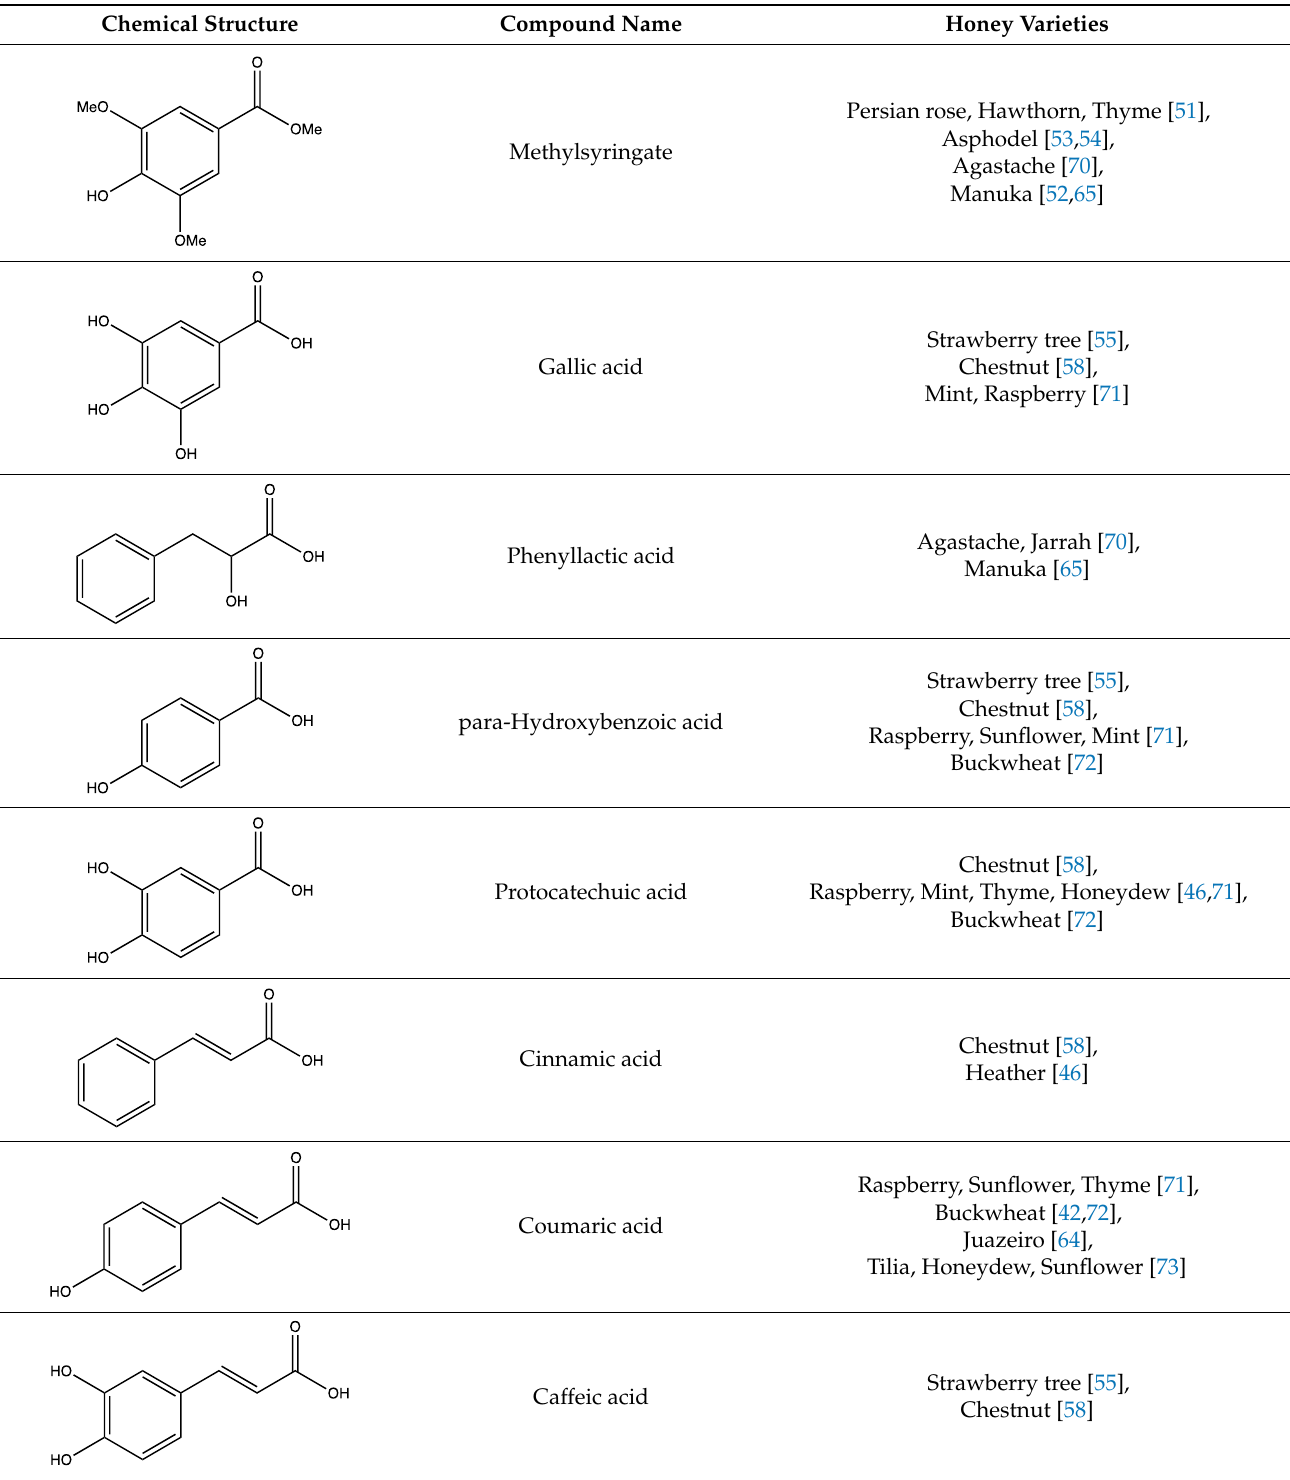
Table 1. Chemical structure of some of the most frequently researched phenolic compounds detected in honey and examples of their occurrence in honeys of different botanical origin.